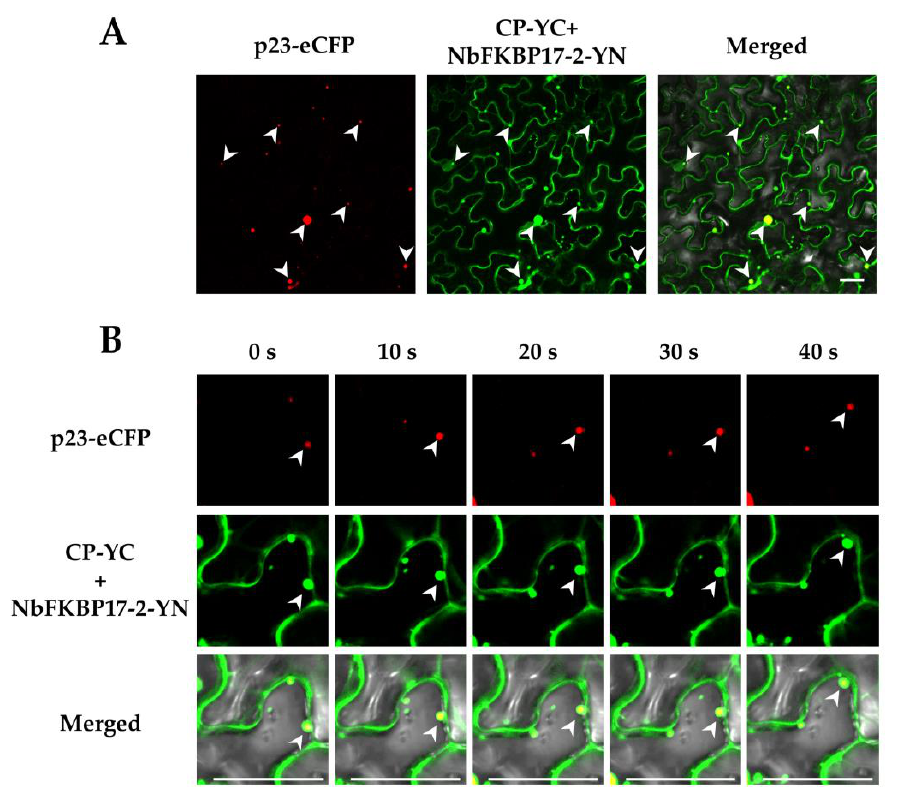
Figure 5. Co-localization ( A ) and integrated time-lapse movement ( B ) of CP/NbFKBP17-2 interaction complexes with p23-eCFP. Arrow heads pointed to p23/CP/NbFKBP17-2 complexes in different channels. Confocal images were taken at 48 hpi. Bars, 20 μm.